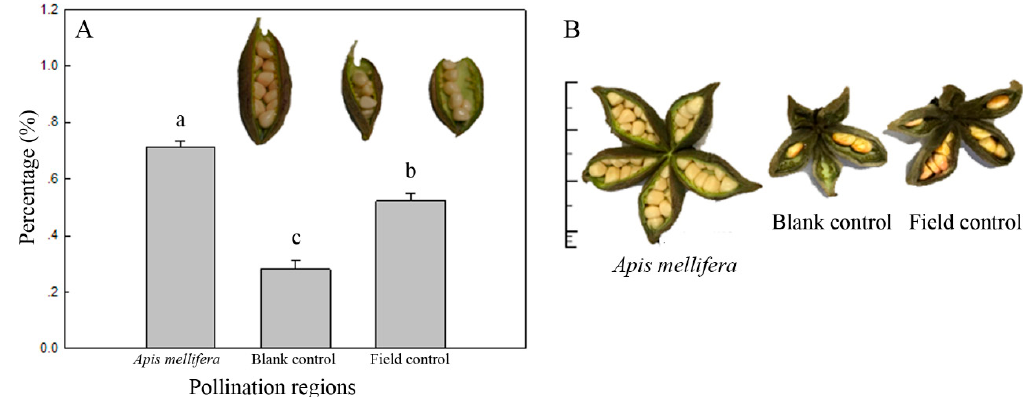
Figure 6. Seed set of the oil tree peony ‘Feng Dan’ in di ff erent pollination areas ( A ) and clustering follicles of the oil tree peony ( B ). Data in the figure are presented as the mean ± standard error. Di ff erent letters above the columns in the figure indicate a significant di ff erence at the 5% level (one-way ANOVA).